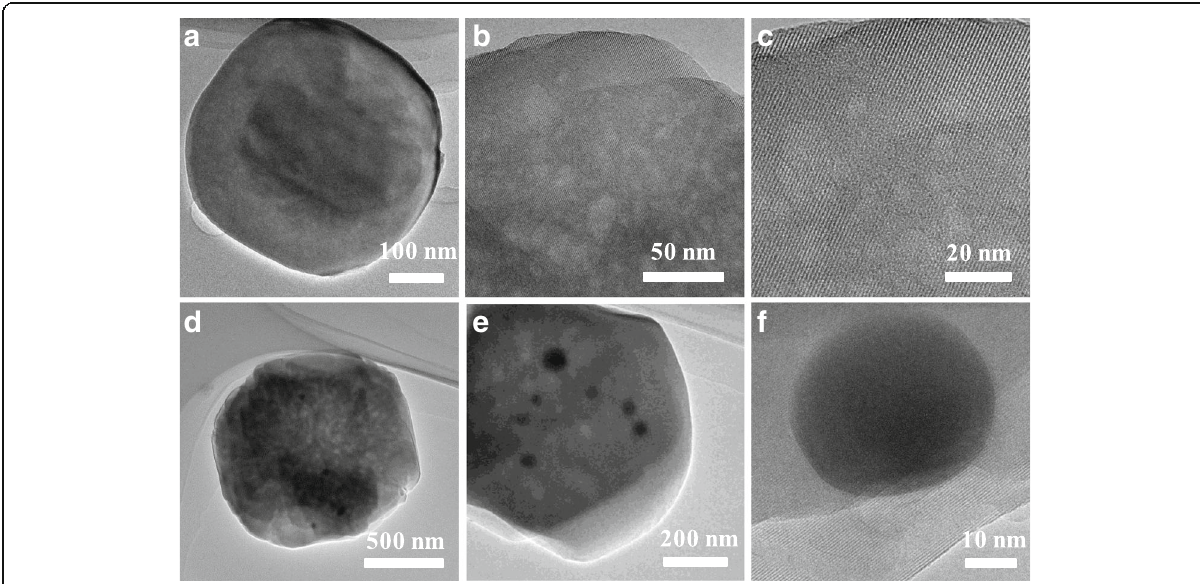
Fig. 2 a – c The TEM and HRTEM images of HPS-1. d – f The TEM and HRTEM images of Ag@HPS-1 catalyst